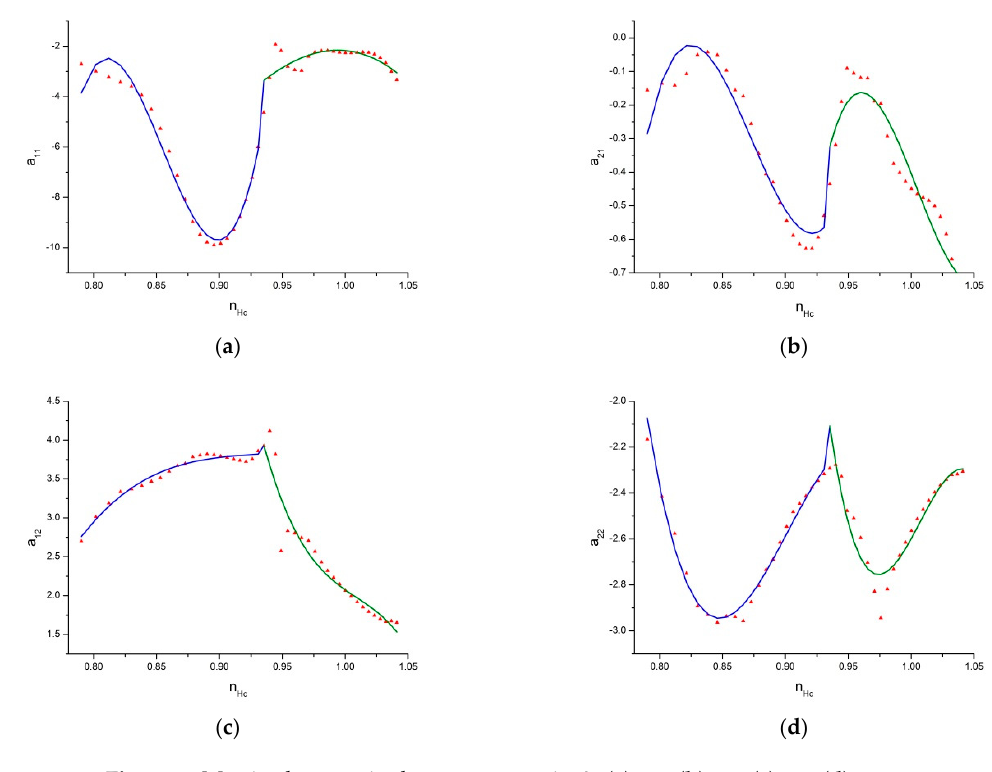
Figure 8. Matrix elements in the system matrix A : ( a ) a 11 ; ( b ) a 21 ; ( c ) a 12 ; ( d ) a 22 .